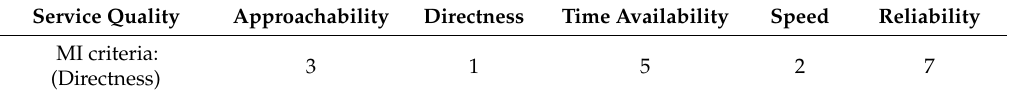
Table 5. Example of evaluating service quality criteria by comparing to the most important one. Service Quality Approachability Directness Time Availability Speed